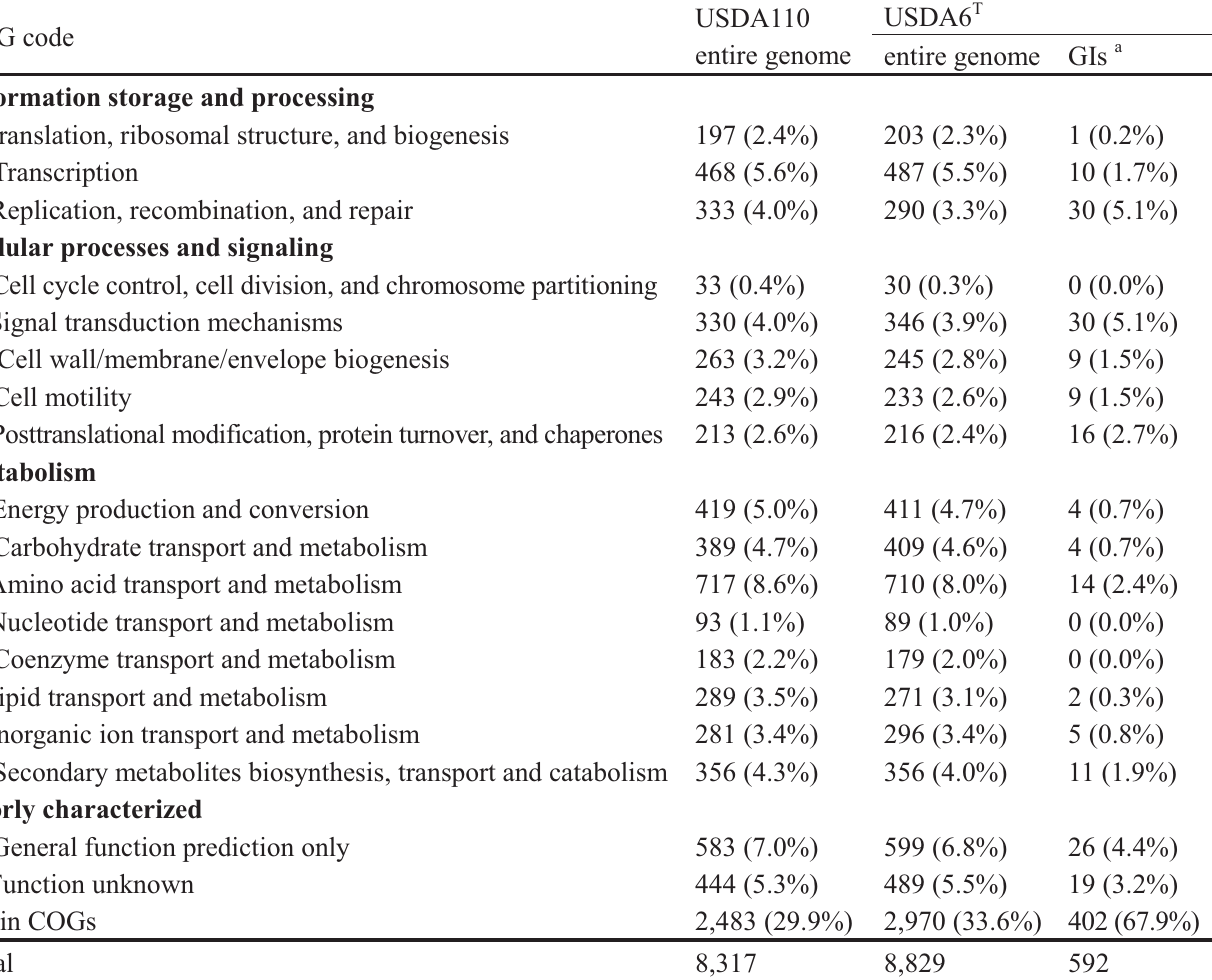
Table 3. Number of protein genes assigned into Clusters of Orthologous Groups (COG) categories. COG code